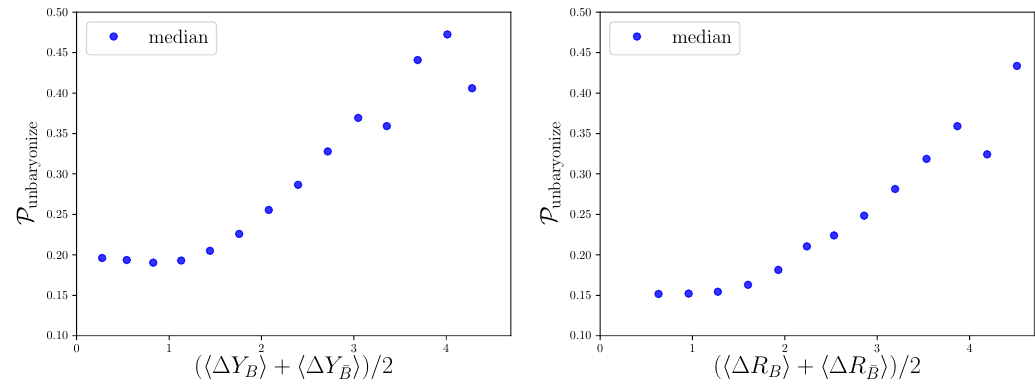
Figure 9 . Average unbaryonization probabilities with respect to the average sum of h (cid:1) Y i and h (cid:1) R i of the constituent quarks of the baryonic